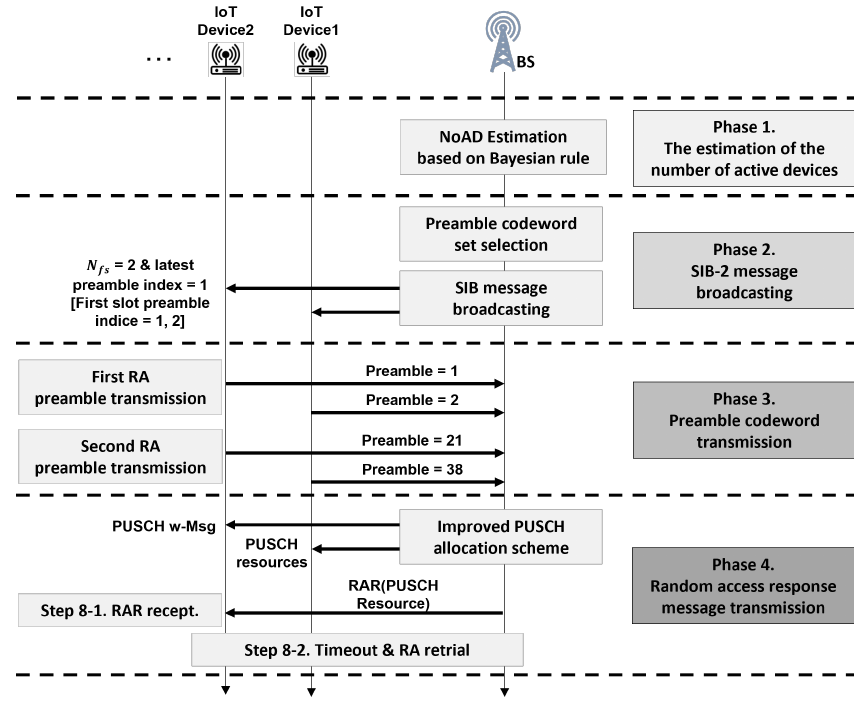
Figure 4. Overall procedures of the proposed CeRA-eSP